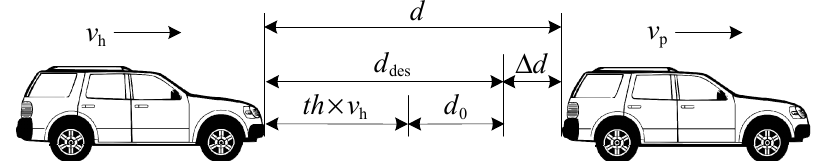
Figure 1. Longitudinal kinematics of the preceding vehicle and the host vehicle.